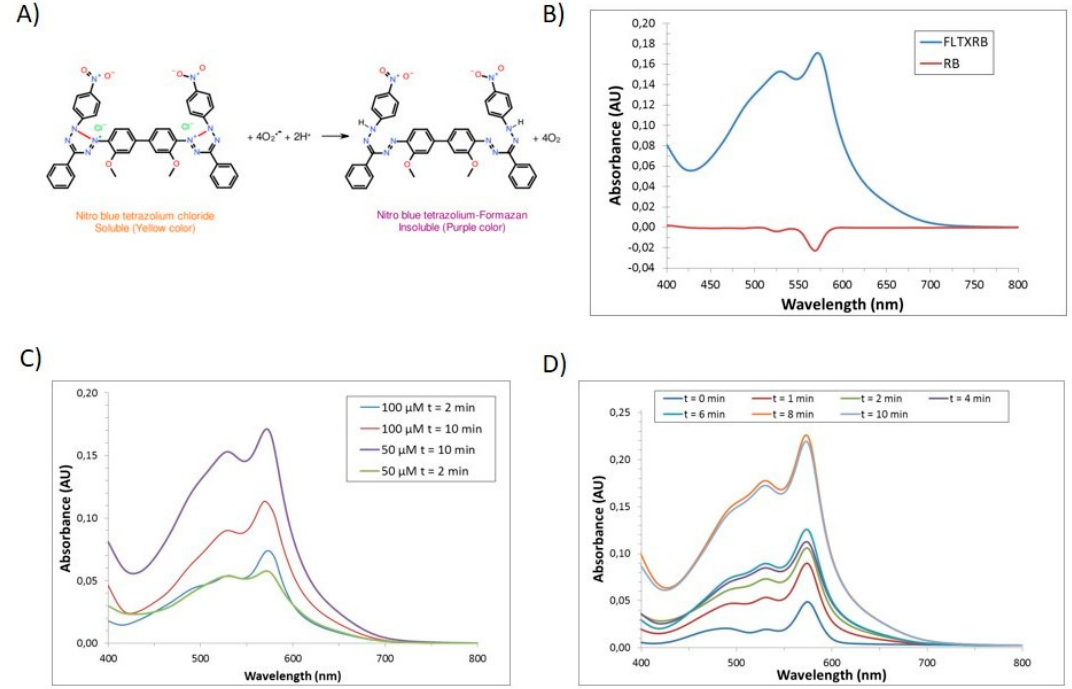
Figure 6. FLTX2-induced ROS generation. ( A ) Superoxide anion-induced formation of nitro blue tetrazolium-formazan. ( B ) Absorption spectra of equimolar FLTX2 and RB solutions after laser irradiation for 10 min. ( C ) Concentration-dependence of FLTX2-induced formazan formation irradiated for 2 or 10 min. ( D ) Time-dependence for FLTX2-induced (50 µM) formazan generation.